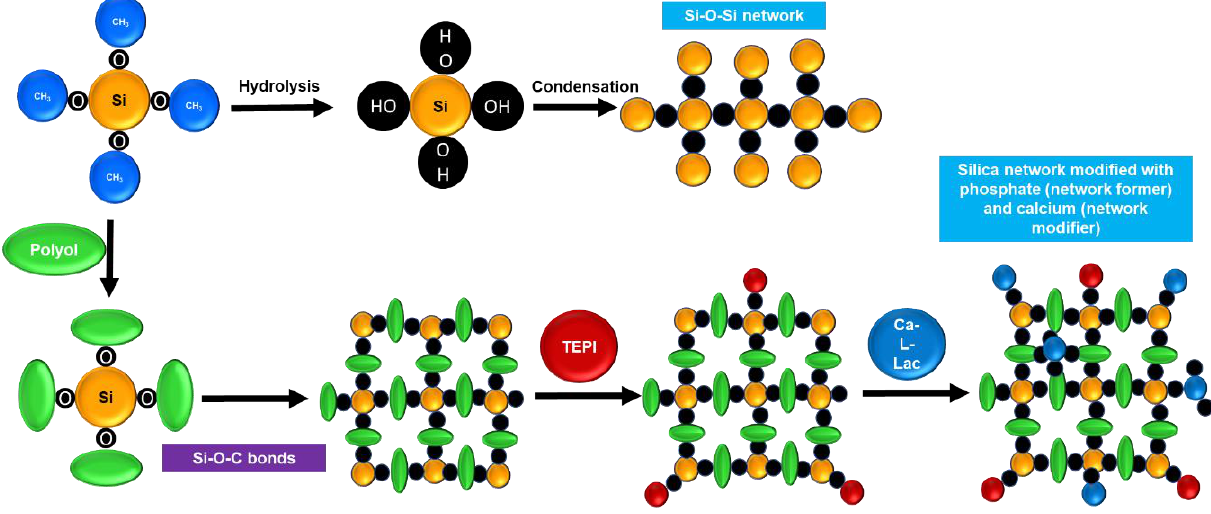
Figure 1. Schematics of conventional Si-O-Si network formation and influence of polyol, TEPI, and Calcium L-lactate in Silica network formation.